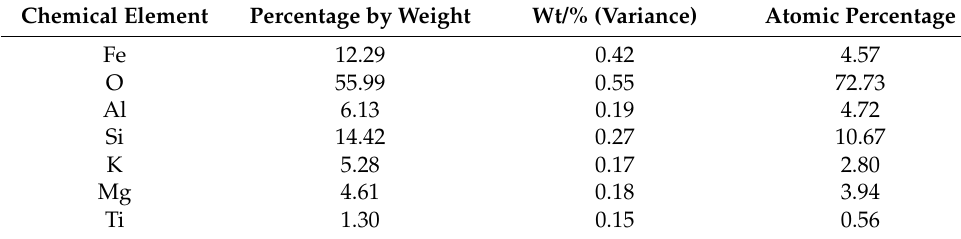
Figure 9. EDS spectrum. Table 4. Composition of Sample